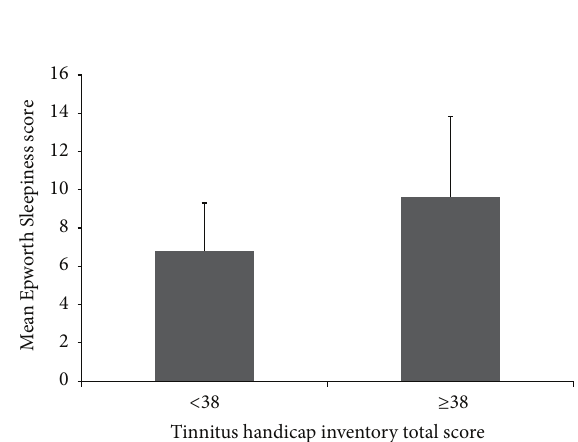
Figure 1: Mean Epworth Sleepiness Scale (ESS) score for Tinnitus Handicap Inventory (THI) total score < 38 and ≥ 38. Vertical bars with caps indicate standard deviations.